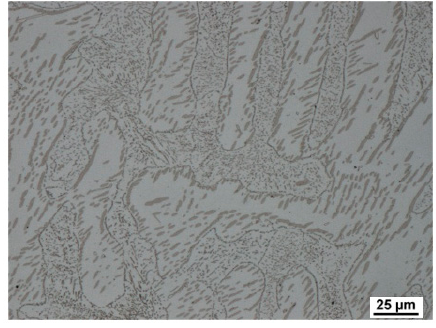
Figure 6. Casting structure of heat